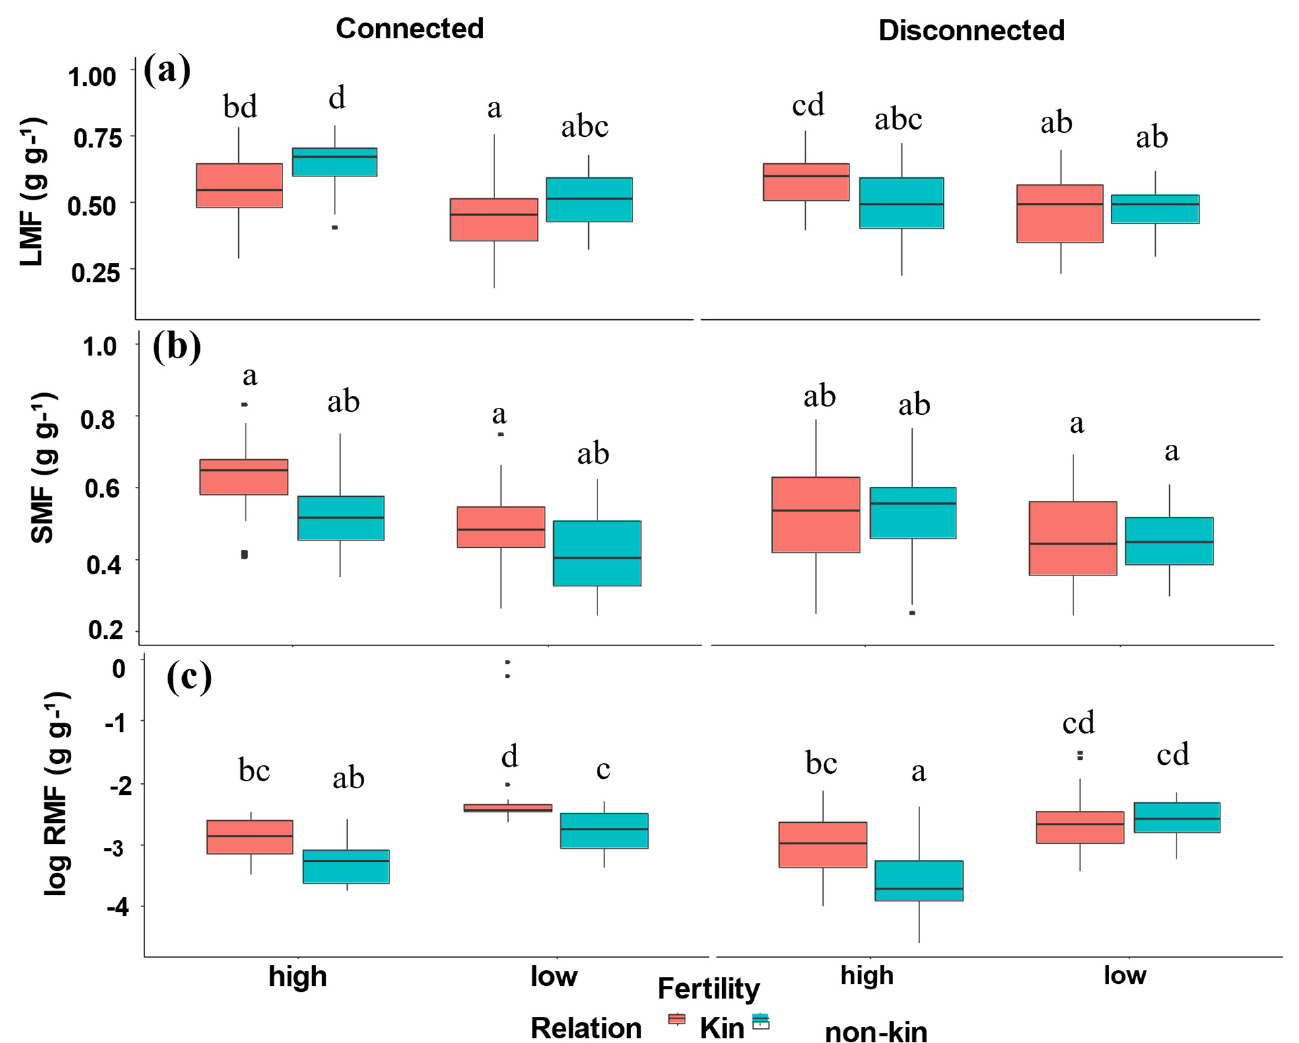
Figure 2. ( a ) Leaf mass fraction (LMF), ( b ) Stem mass fraction (SMF), and ( c ) Root mass fraction (RMF) of kin and non-kin in all treatment combinations including low- versus high-nutrient connected and low- versus high-nutrient disconnected treatments. Common letters within each panel indicate no statistically significant difference among the treatment pairs in that panel (based on Tukey HSD tests).